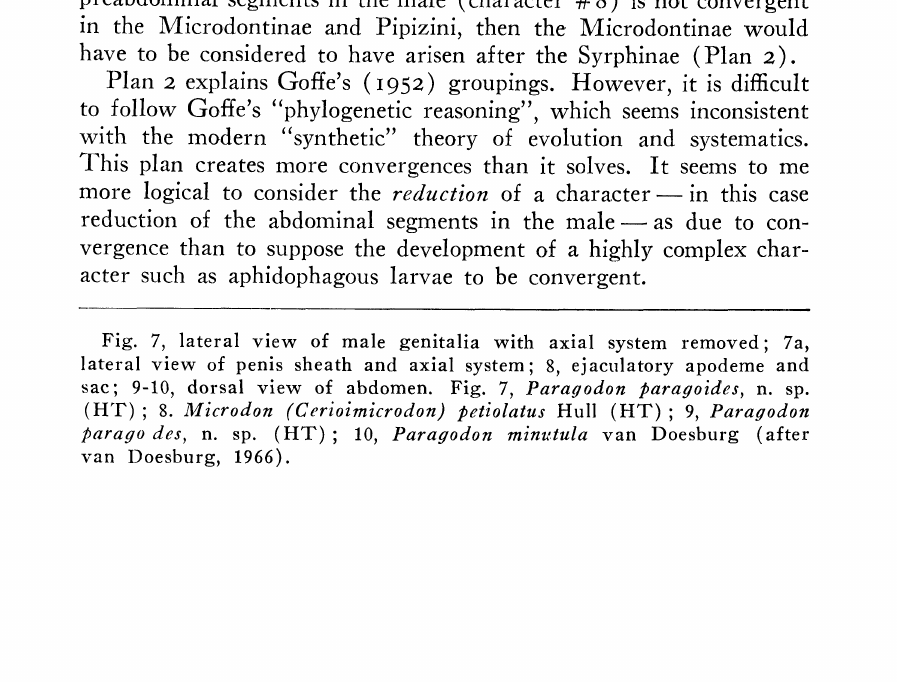
Fig. 7, lateral view of male genitalia with axial system removed; 7a, lateral view of penis sheath and axial system; 8, ejaculatory apodeme and sac; 9-10, dorsal view of abdomen. Fig. 7, Par’agodon paragoides, n. sp. (HT); 8. Microdon (Cerioimicrodon) petiolatus Hull (HT); 9, Para7odon para7o des, n. sp. (HT); 10, Paragodon minutula van Doesburg (after van Doesburg,